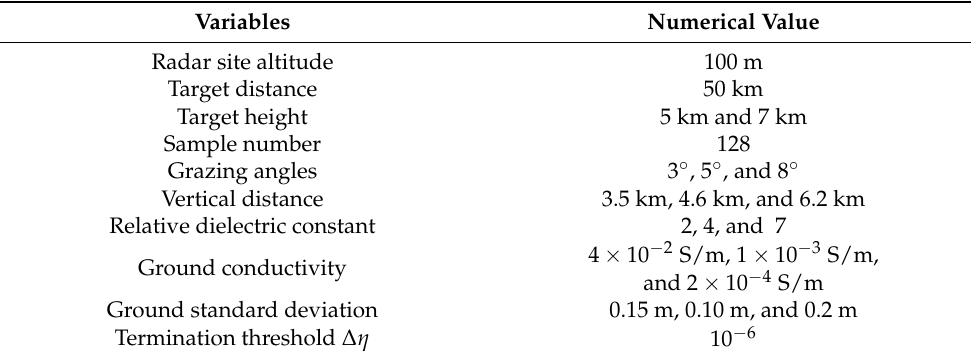
Table 3. Parameter list for the second